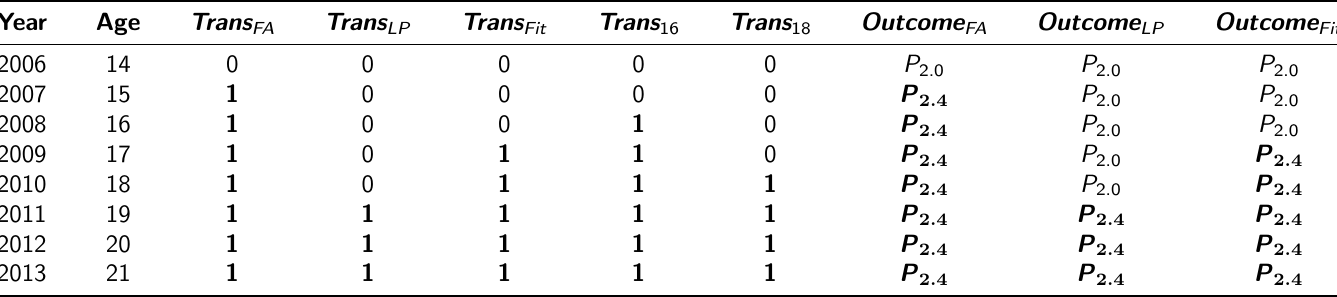
Table 1: Example (dummy) data for the